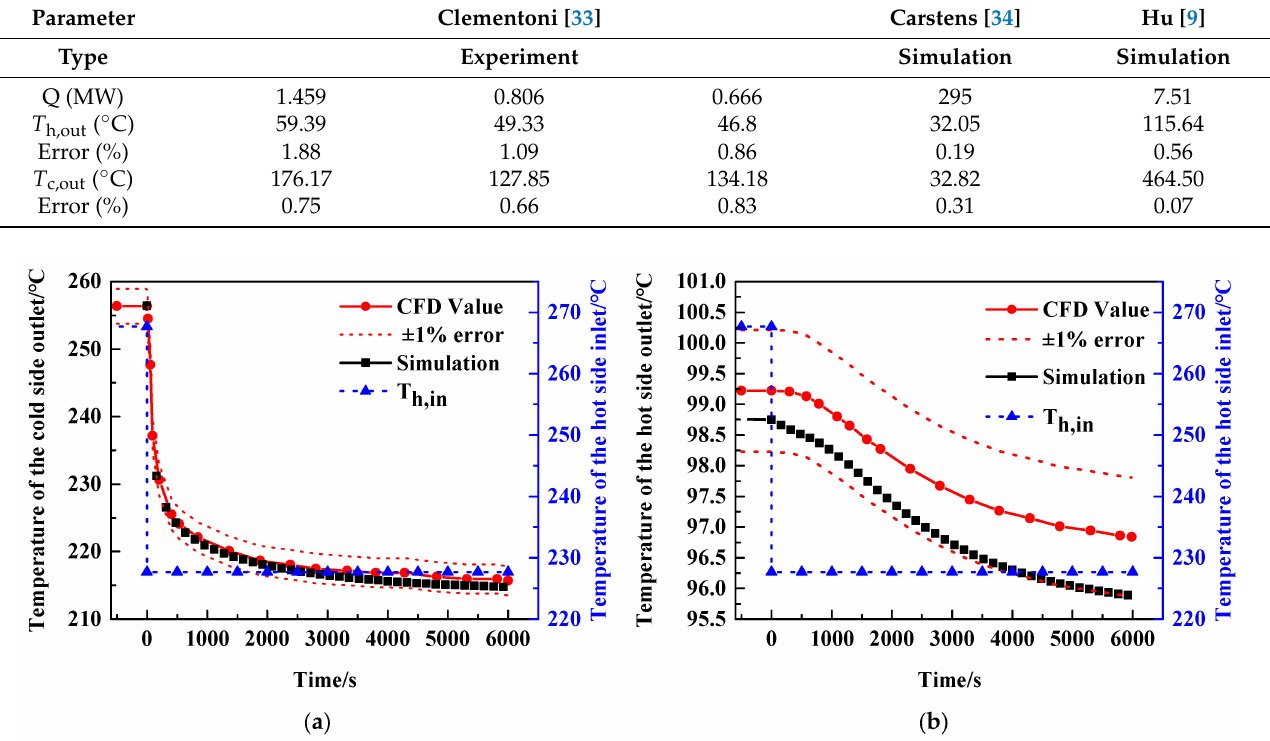
Figure 5. Dynamic validation of the heat-exchanger model: ( a ) temperature change at the cold-side outlet; ( b ) temperature change at the hot-side